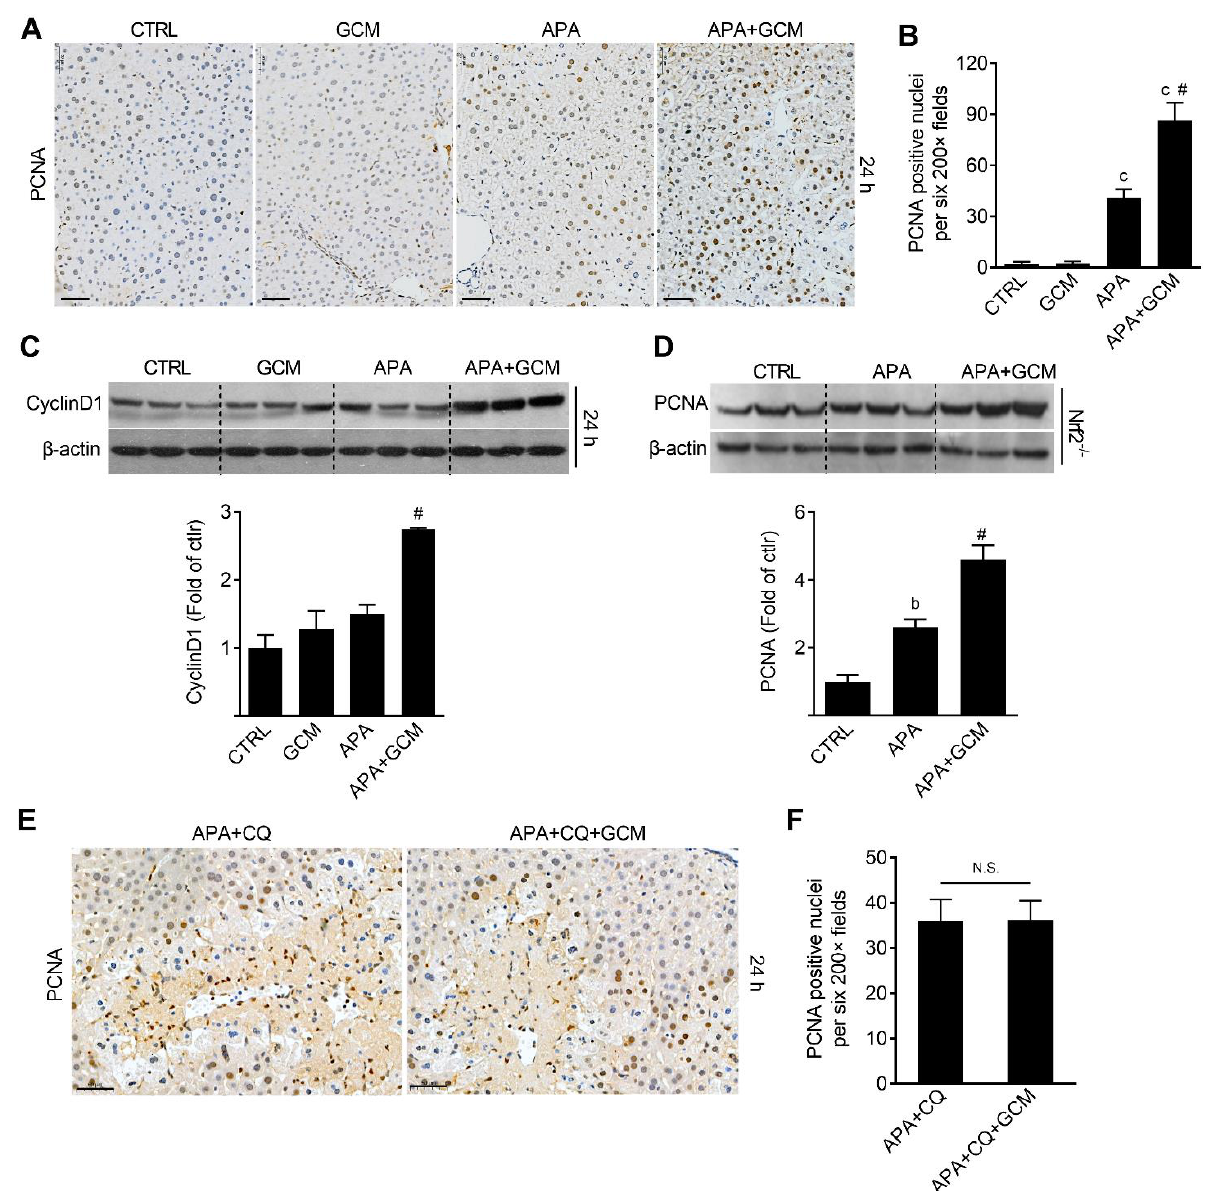
Figure 6. Glycycoumarin (GCM) promotes liver regeneration in wild-type and Nfr2 knockout mice. Mice were treated with 300 mg/kg of APA followed by 100 mg/kg of GCM 6 and 18 h after APA, and the livers were harvested for analysis 24 h after the APA overdose. ( A ) Representative immunohistochemical staining images of PCNA in liver tissues. ( B ) Quantification of the PCNA-positive hepatocyte nuclei. Immunoblot analysis of the whole-liver homogenate for ( C ) CyclinD1 in wild-type mice and ( D ) PCNA in Nrf2 knockout mice and the corresponding densitometry normalized to β-actin ( E , F ). Mice were treated with 300 mg/kg of APA followed by a CQ or/and GCM treatment 6 and 18 h after APA. ( E ) Representative immunohistochemical staining images of PCNA in liver tissues. ( F ) The quantification of PCNA-positive hepatocyte nuclei. Scale bar = 50 μm. Data are presented as the mean ± SEM. b: p < 0.01; c: p < 0.001 compared with the vehicle control. # p < 0.05 compared with the corresponding APA-treated group. N.S.: No significance.